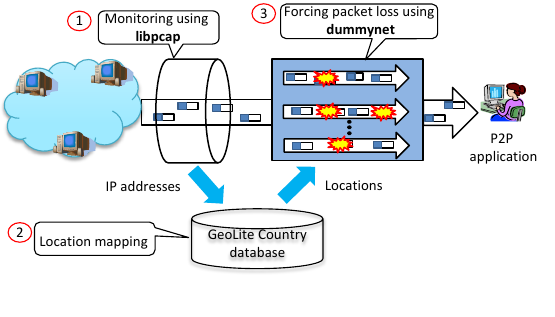
Fig. 3. The implementation of PLS.